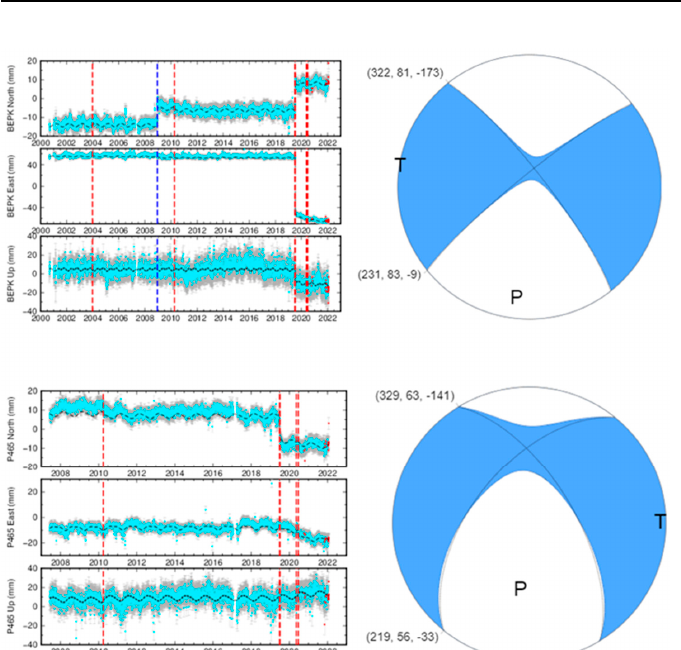
Figure 4. Directional components and moment tensors of the two events. Top left : GPS station BEPK: Long Valley Network. North, east, and up components as a function of time over the last 15 years (start date 1 July 2007) for the M W 7.1 Ridgecrest earthquake. Top right : Ridgecrest earthquake moment tensor. Principal axes (T = Tension, P = Pressure and N = Null) T 277°, P 186°, N 14°. Bo tt om left : GPS station P465: Long Valley Network. North, east, and up components of the station as a function of time over the last 15 years (start date 1 July 2007) for the M W 5.8 Owens Lake earthquake. Bo tt om right : moment tensor. T 7°, 92°, P 46°, 190°. The sources of the directional o ff sets and mo- ment tensors are provided in Table 2.